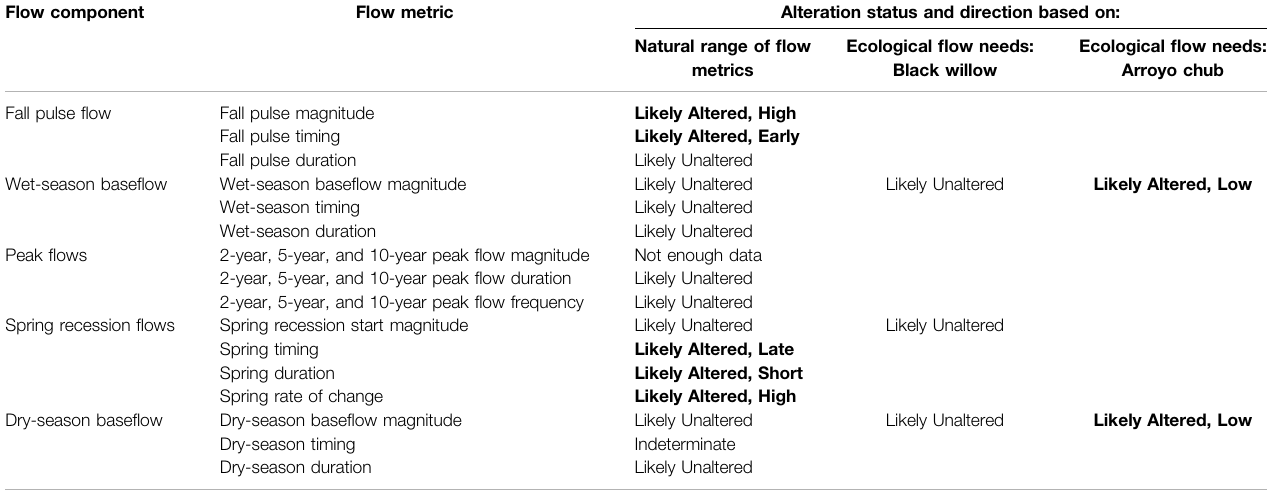
TABLE 6 | Alteration status and direction for functional fl ow metrics comparing current fl ows to natural ranges and ecological fl ow needs for willow and arroyo chub. Likely altered statuses are bolded. Flow